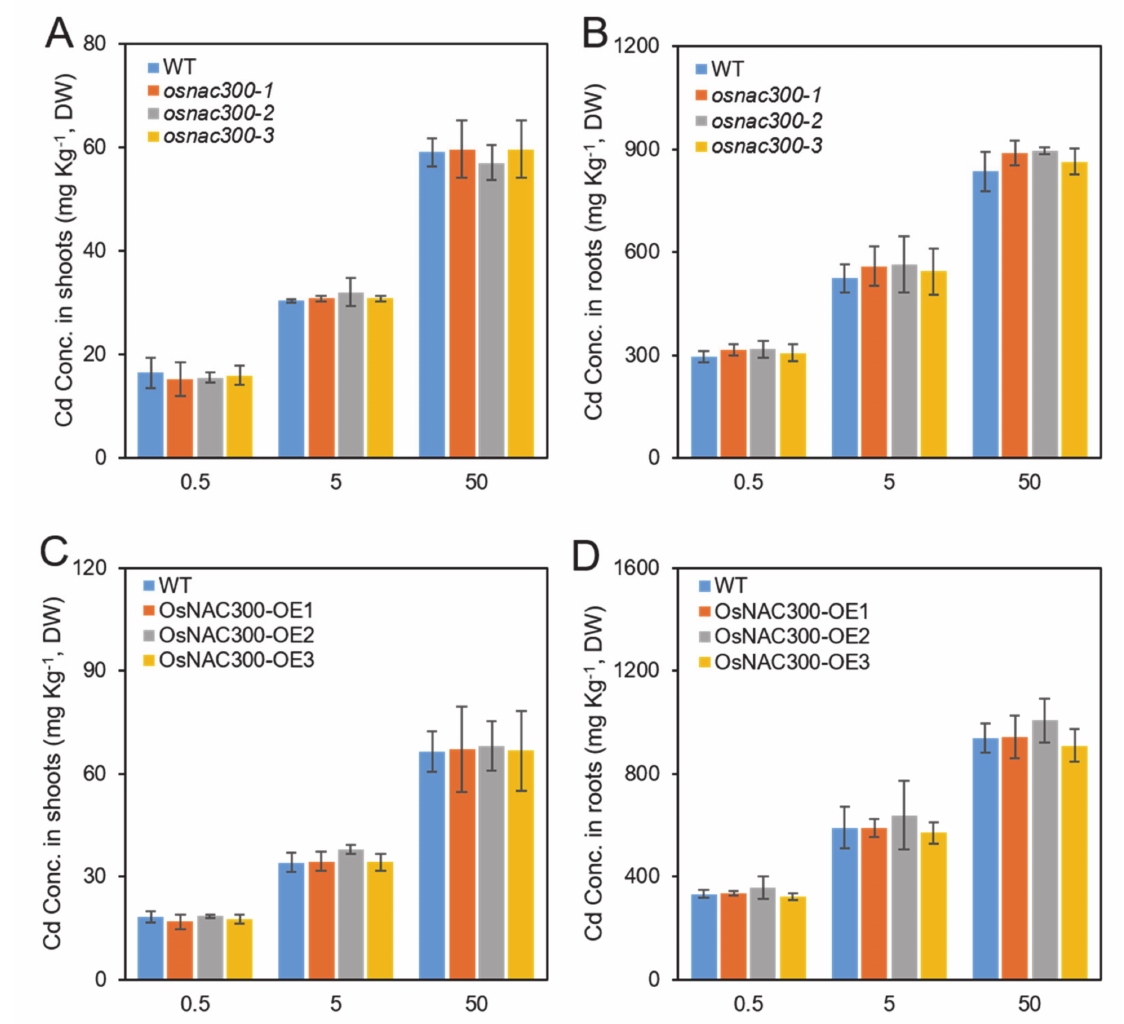
Figure 5. Cd concentrations of osnac300 mutants and overexpression lines. ( A , B ) Concentration of Cd in the shoots ( A ) and the roots ( B ) of osnac300 knockout lines. ( C , D ) Concentration of Cd in the shoots ( C ) and the roots ( D ) of osnac300 overexpression lines. 2-week-old rice seedlings were grown on 0.5, 5 or 50 µ M CdCl 2 for 3 days. The Cd concentration in the roots and shoots was determined by ICP-MS. Data are means ± SD of four biological